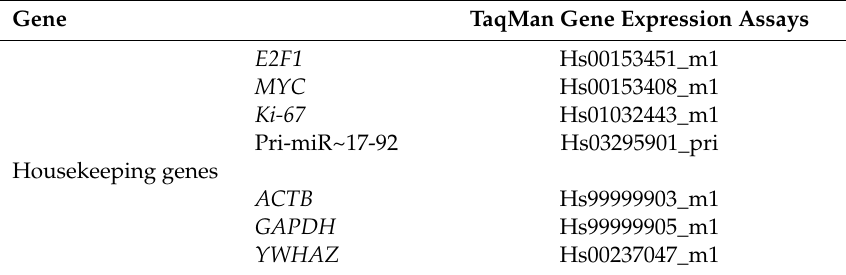
Table 1. TaqMan Expression Assays chosen (Life